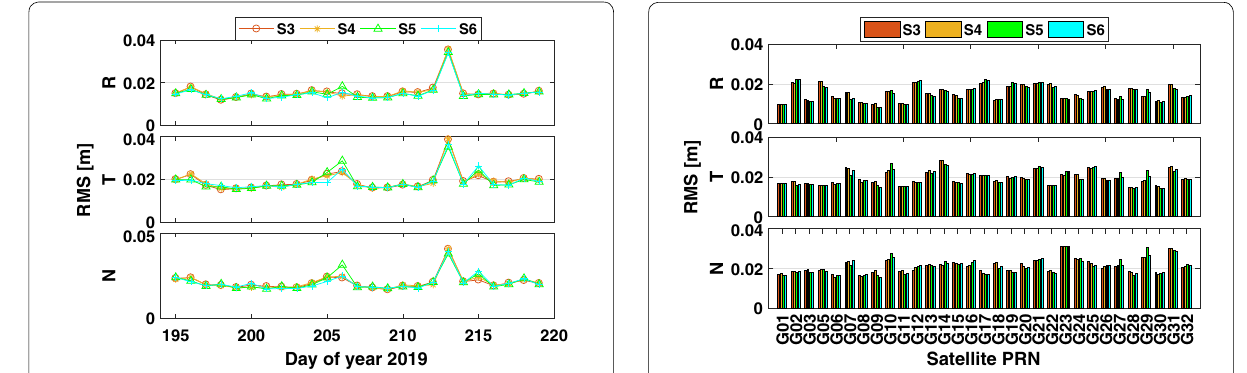
Fig. 3 Average orbit accuracy of each POD arc of GPS